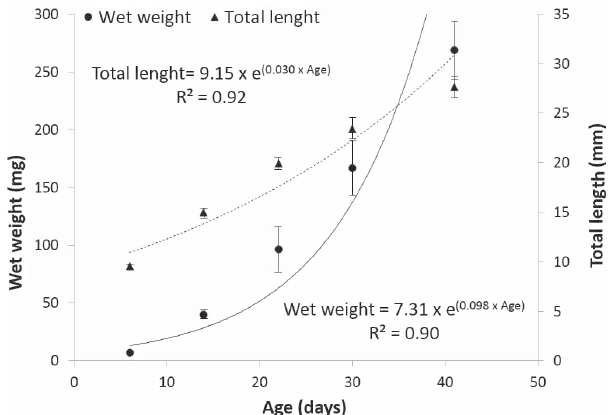
Fig. 1. Wet weight (mg) and total length (mm) of Parachromis dovii (mean ± SD, n=30) during experimental period.